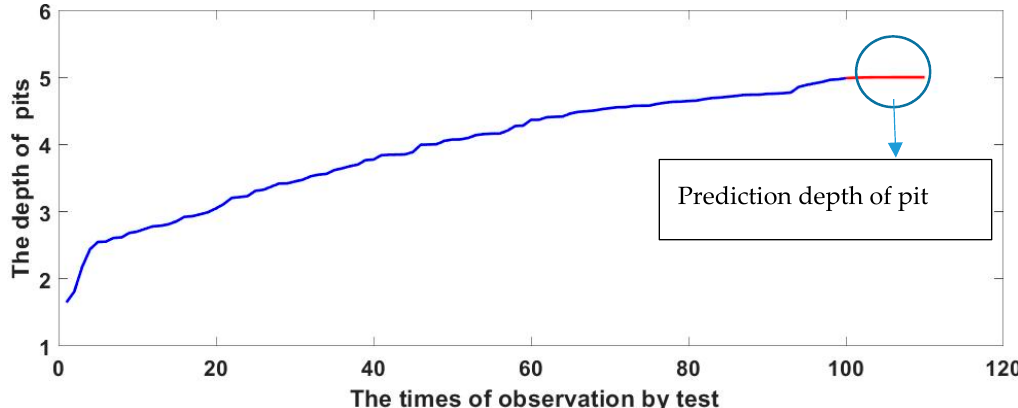
Figure 12. Pit prediction model.